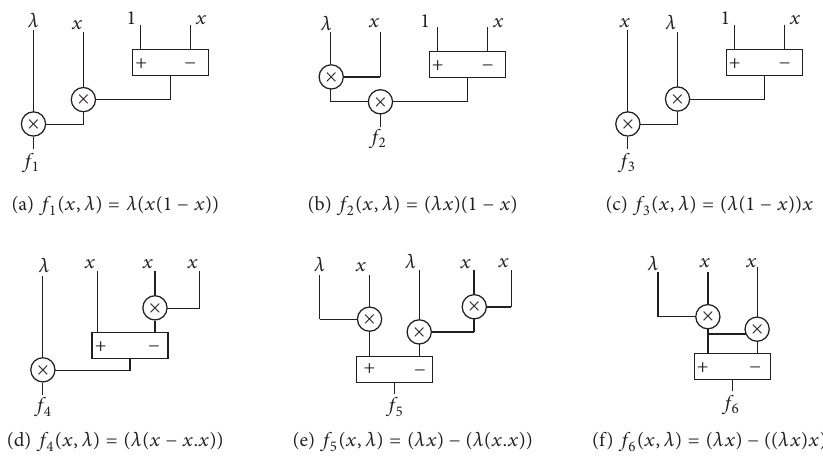
Figure 2: Six different maps in fixed-point